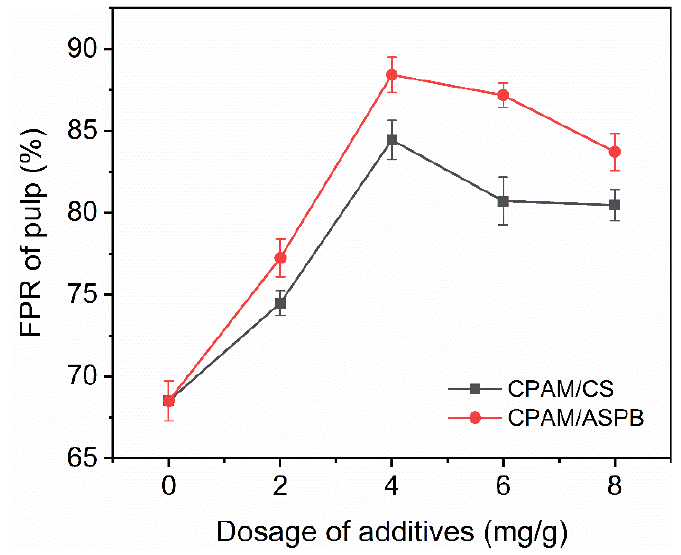
Figure 7. Retention of pulp in the dual-component system. CPAM fixed at 1.5 mg/g.